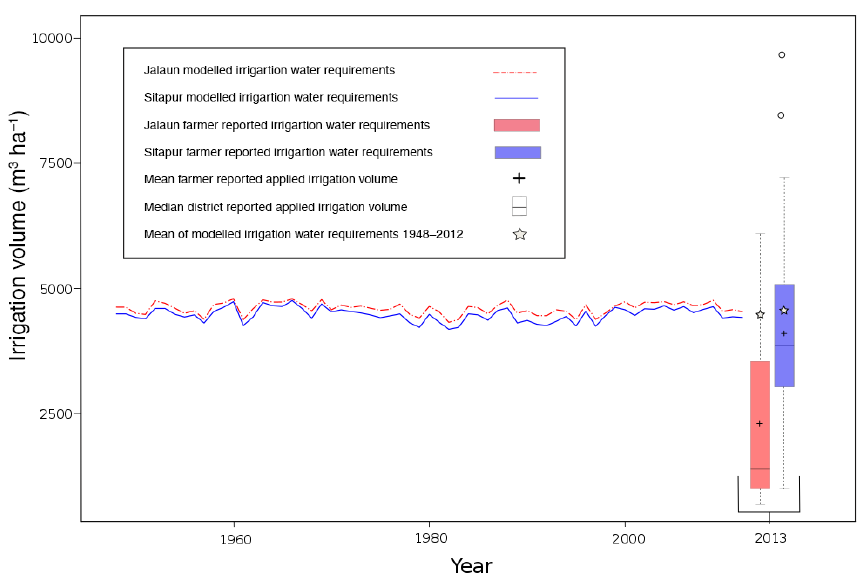
Figure 7. Differences between wheat irrigation volumes reported by farmers (boxplots) and modelled irrigation water requirements (time series). The mean modelled irrigation requirements from 1948 to 2012 are also shown (stars on boxplots) to aid comparison with 2013 reported information. The boxes represent the 25 to 75 percentiles; the whiskers represent 1.5 times the interquartile range (IQR). Circles represent outliers: values which exceed 1.5 times the